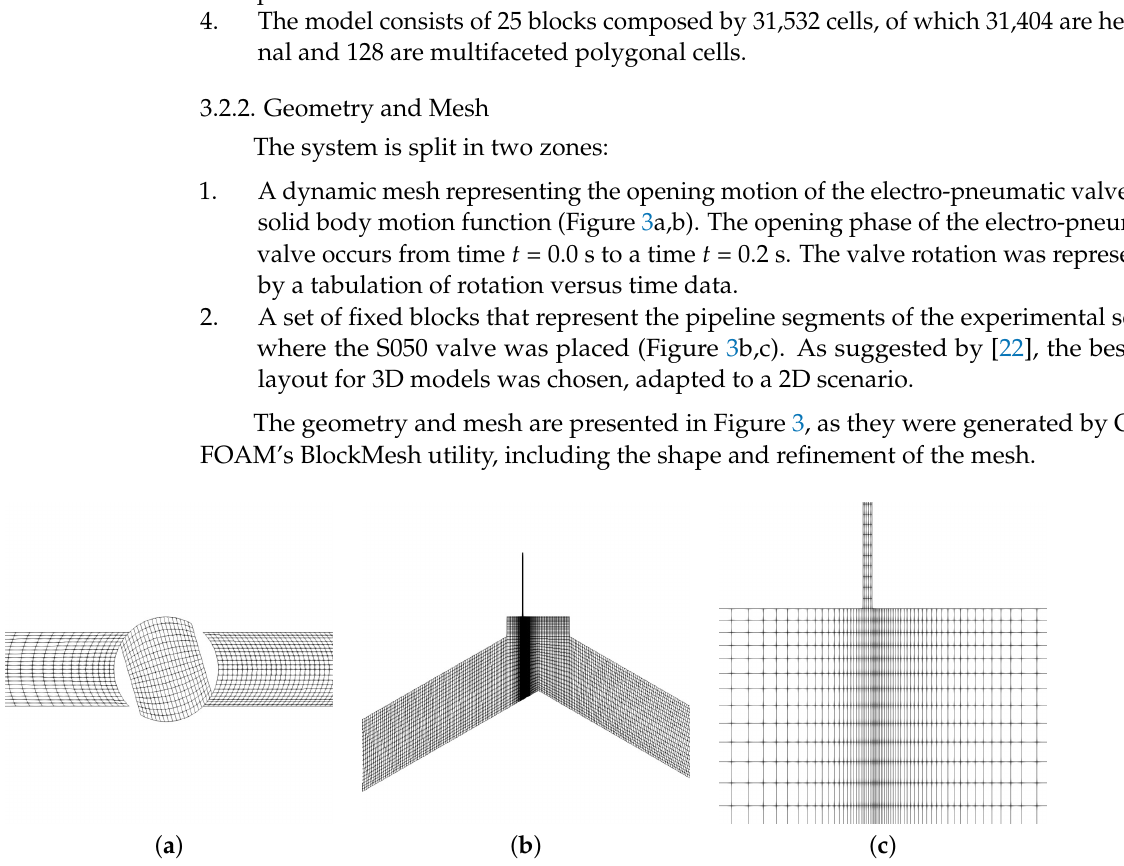
Figure 3. Geometry and mesh of the CFD model. ( a ) Opening movement of the electro-pneumatic. ( b ) Mesh structure in the placement of the S050 air valve. ( c ) Refinement towards the inlet port of the S050 air